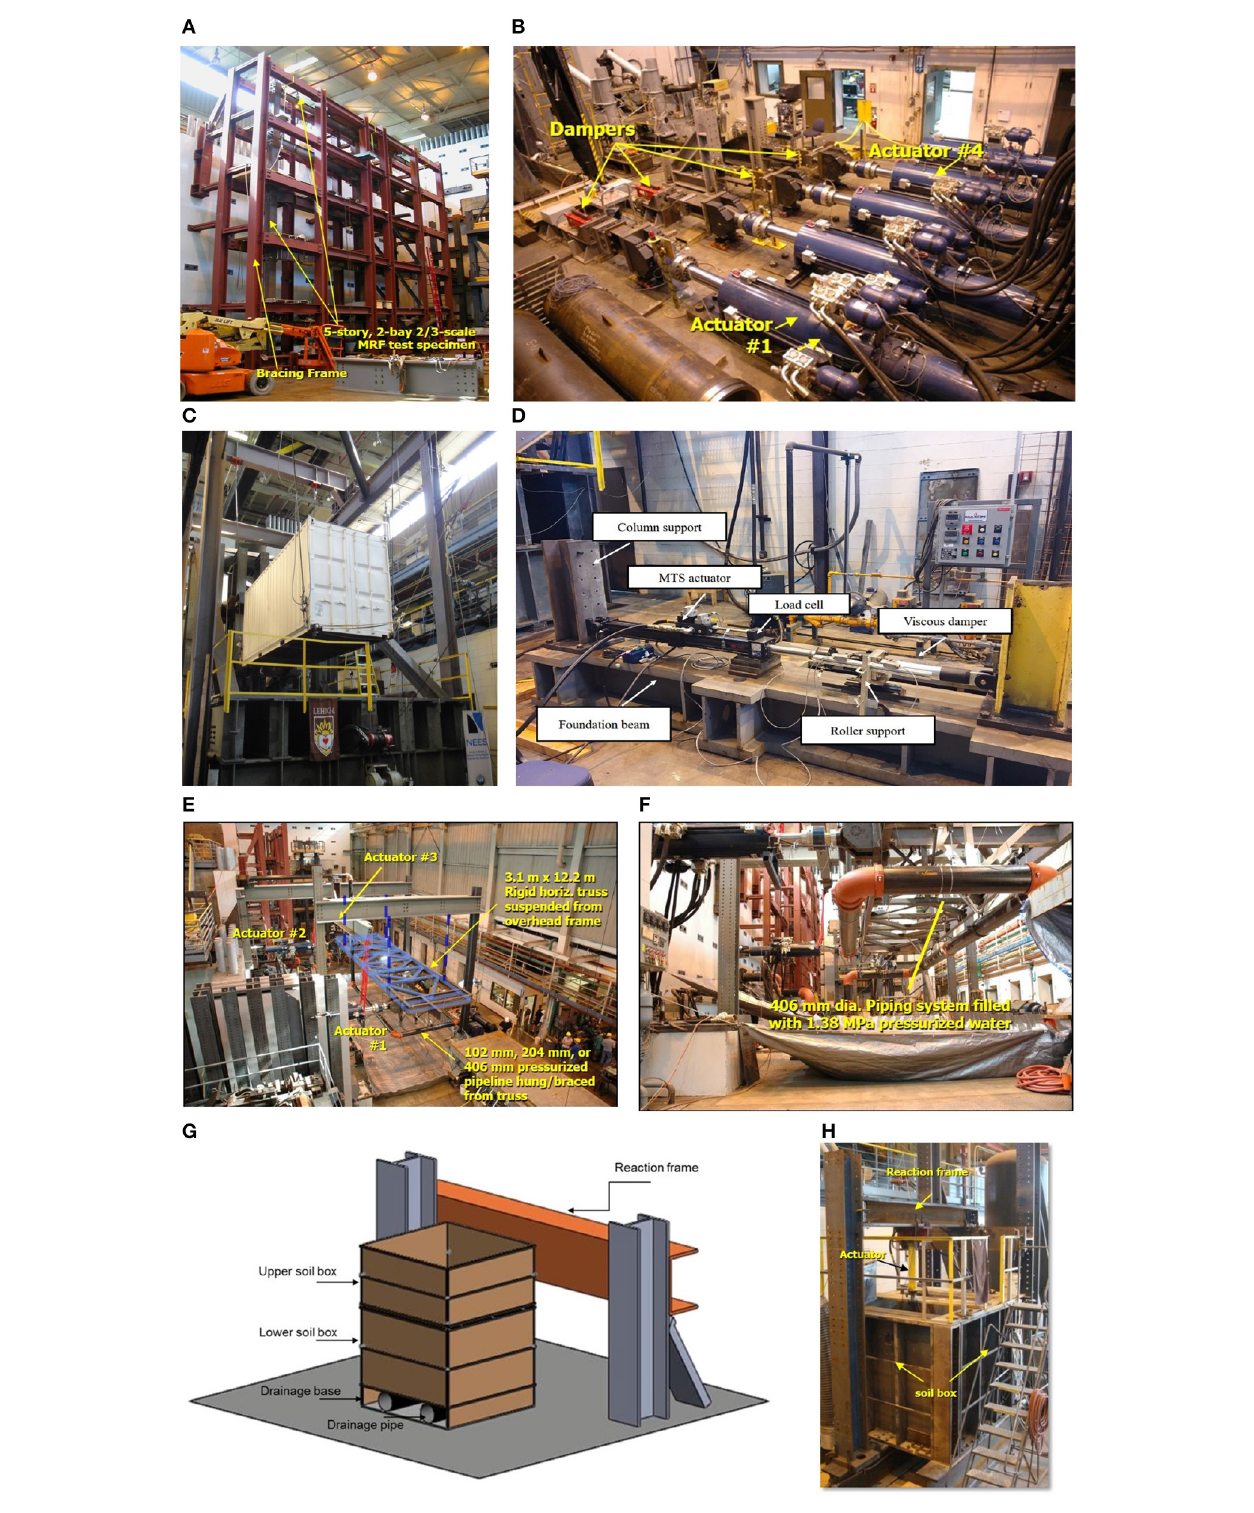
FIGURE 2 | NHERI Lehigh EF testbeds: (A) lateral force-resisting system characterization testbed; (B) full-scale damper testbed; (C) tsunami debris impact force testbed; (D) Lehigh Real-Time Cyber-Physical Structural Systems Laboratory testbed; (E) non-structural component multi-directional dynamic loading testbed being used for real-time multi-directional hybrid simulation of a building piping system; (F) piping system details; and soil-foundation structure interaction testbed; (G) schematic; and (H) photograph.